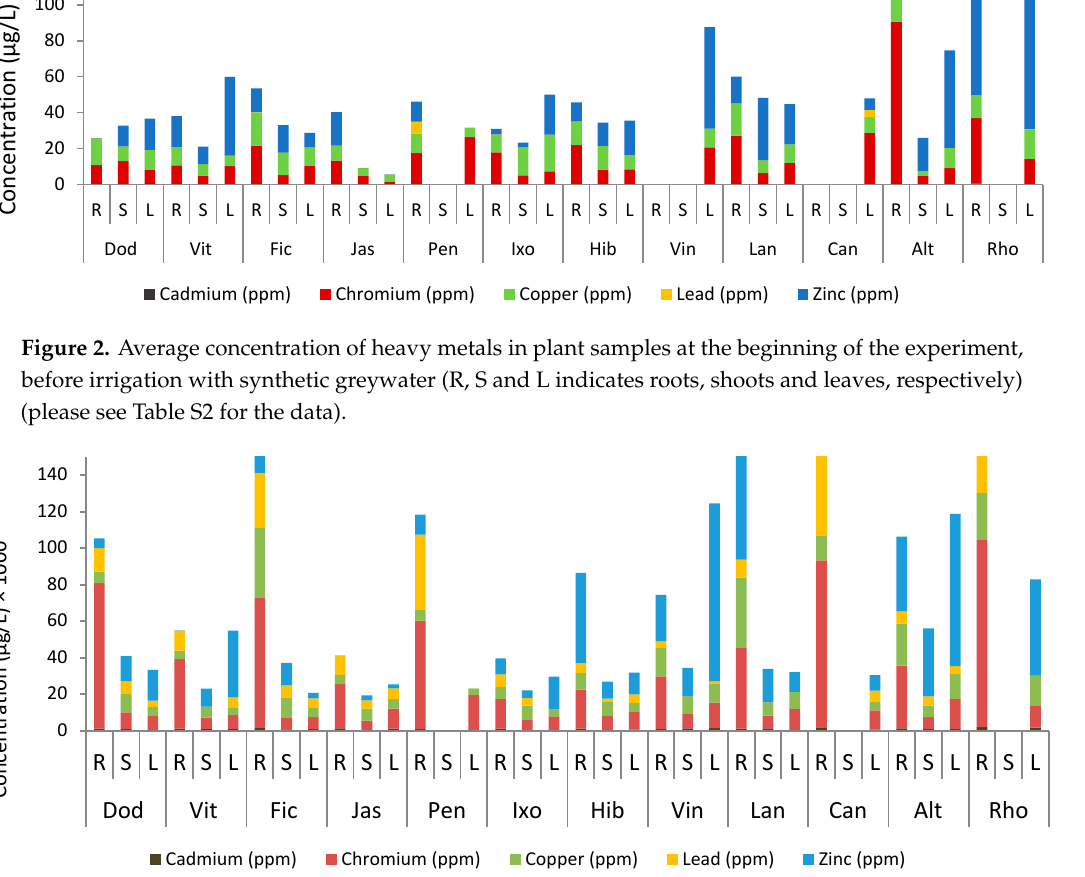
Figure 3. Average concentration of heavy metals in plant samples at the end of the experiment, after irrigation with synthetic greywater (R, S and L indicates roots, shoots and leaves, respectively) (please see Table S3 for the data).